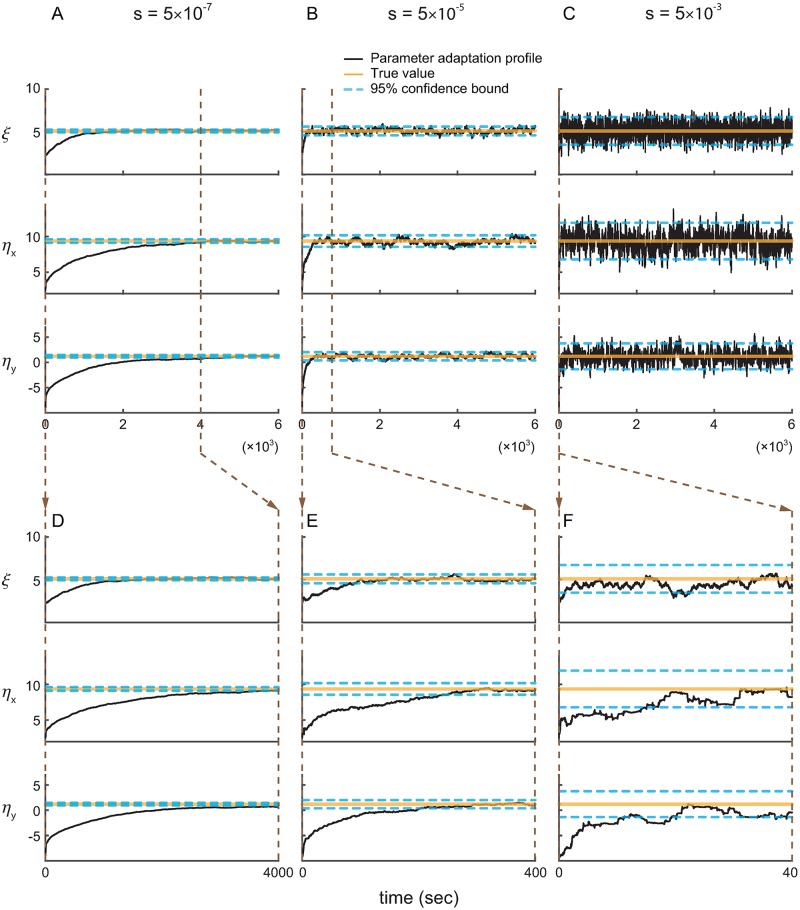
Parameter adaptation profiles confirm the accuracy of the calibration algorithm with continuous signals.(A–C) show sample adaptation profiles of the model parameters ψt|t for different learning rates s in ascending order. For each learning rate, the estimated parameters are within the analytically-computed 95% confidence bounds by the calibration algorithm about 96% of the time, demonstrating the accuracy of the calibration algorithm.